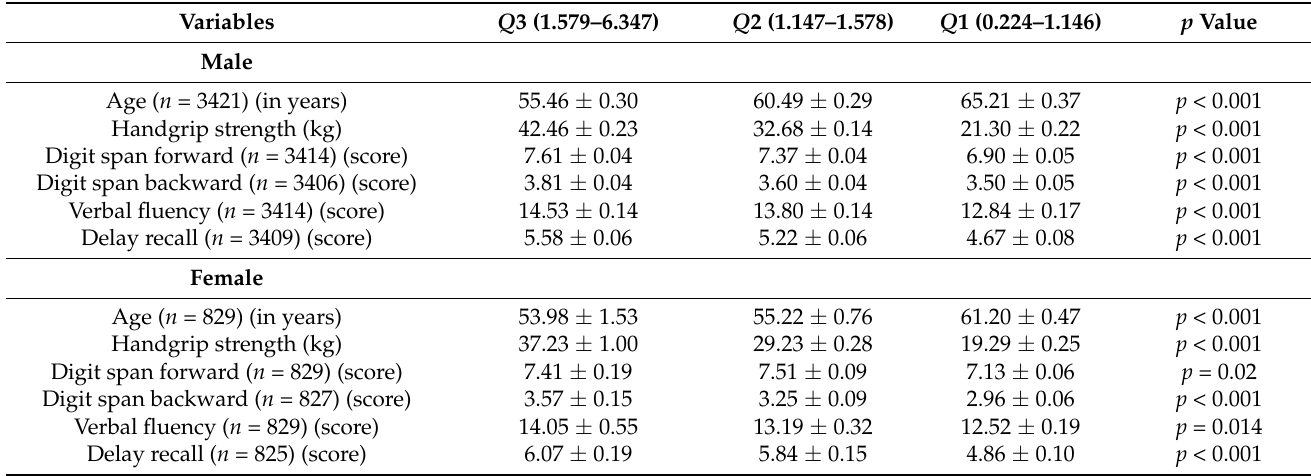
Table 2. Participants’ characteristics based on the tertiles of handgrip strength in male and female participants.